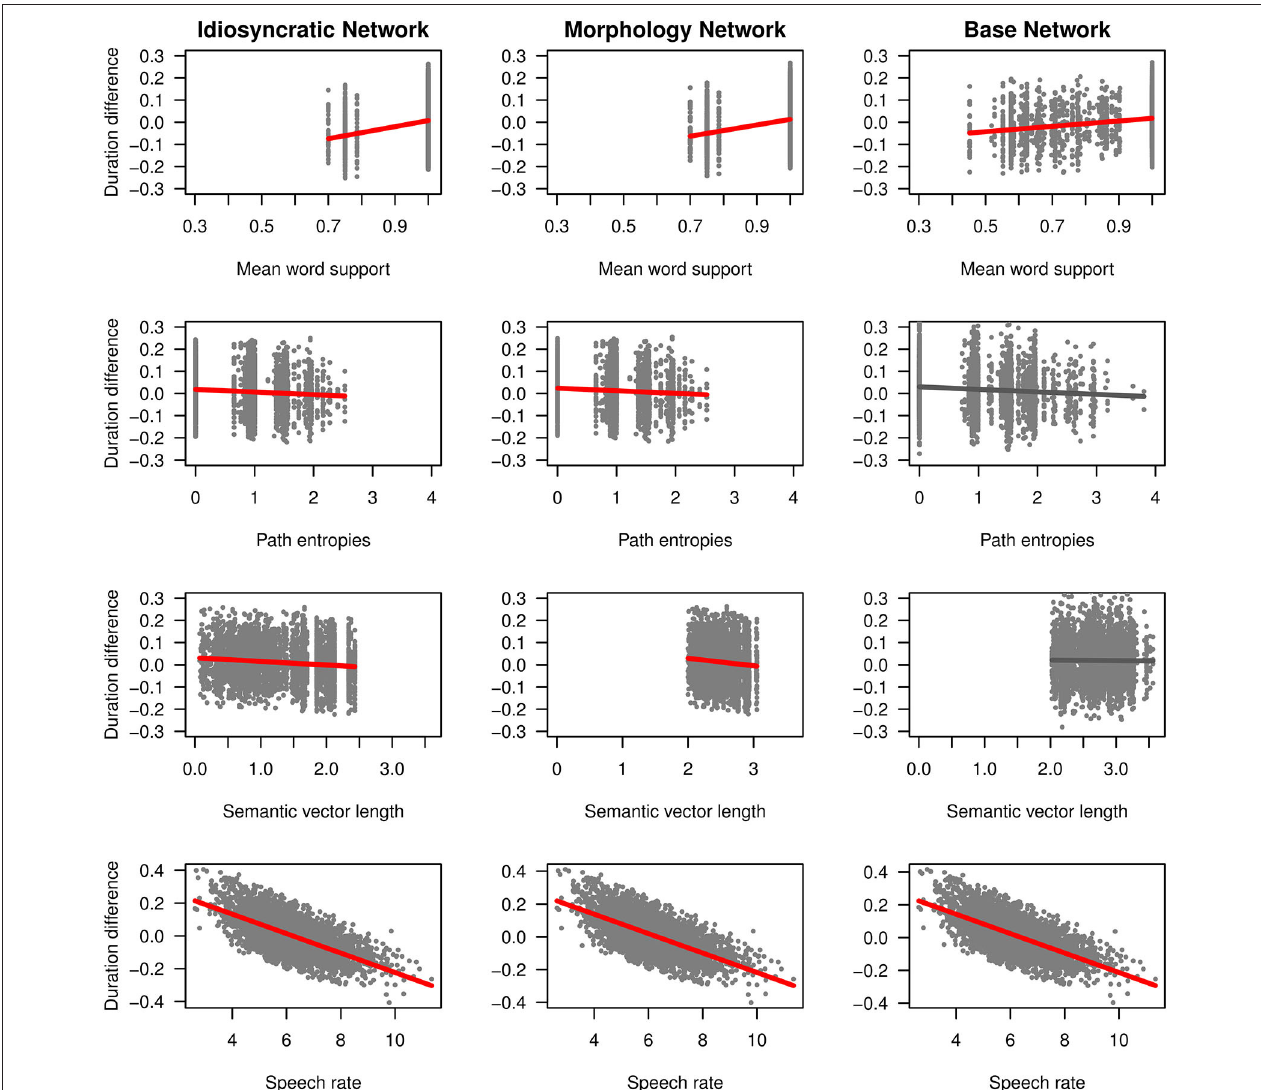
FIGURE 4 | Effects on duration difference in the mixed-effects regression models for the Idiosyncratic Network variables (left column), the Morphology Network variables (middle column) and the Base Network variables (right column). Red regression lines indicate significant effects from the final models, gray regression lines indicate non-significant effects from the initial models before the non-significant predictors were excluded.